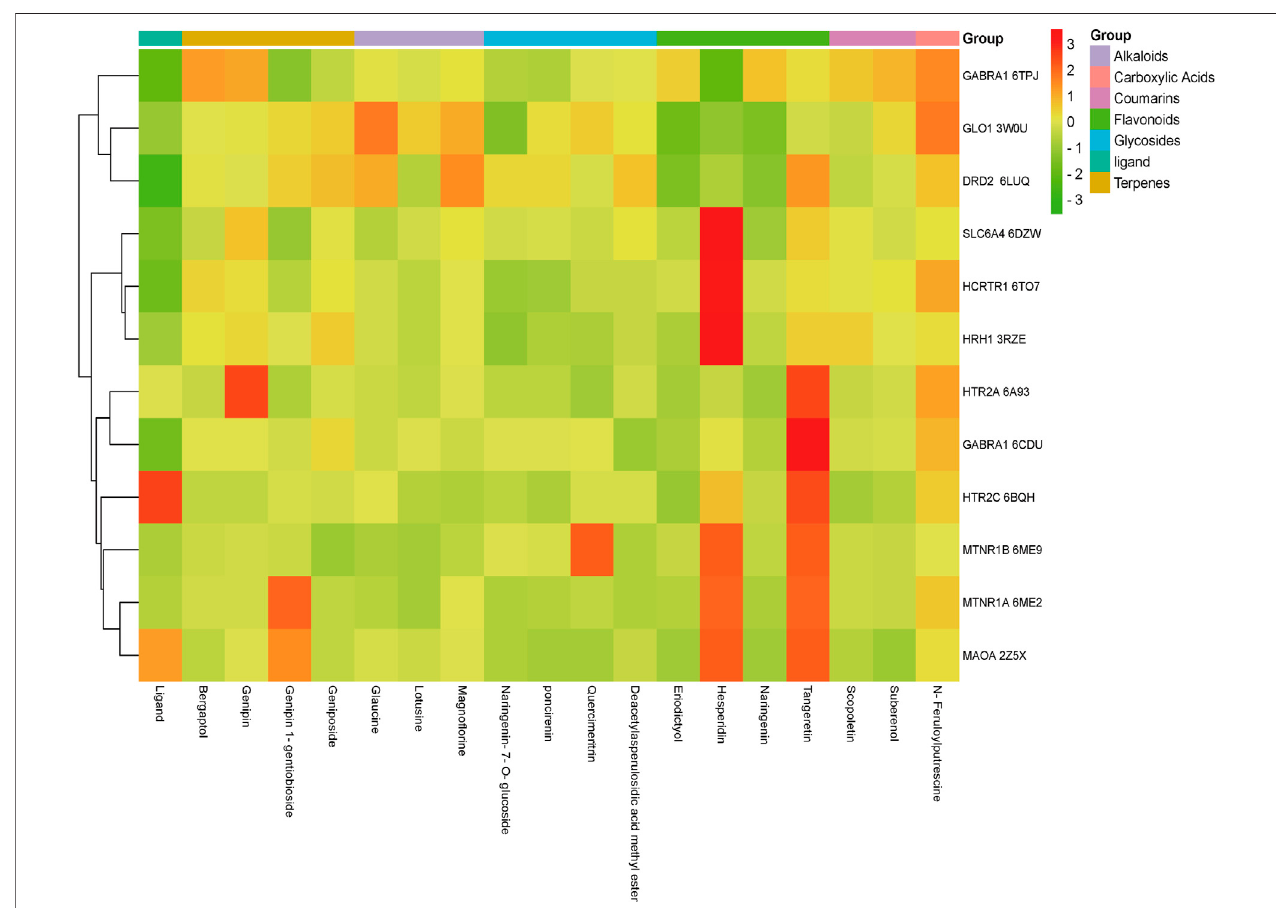
FIGURE 7 | The heat map of molecular docking results.